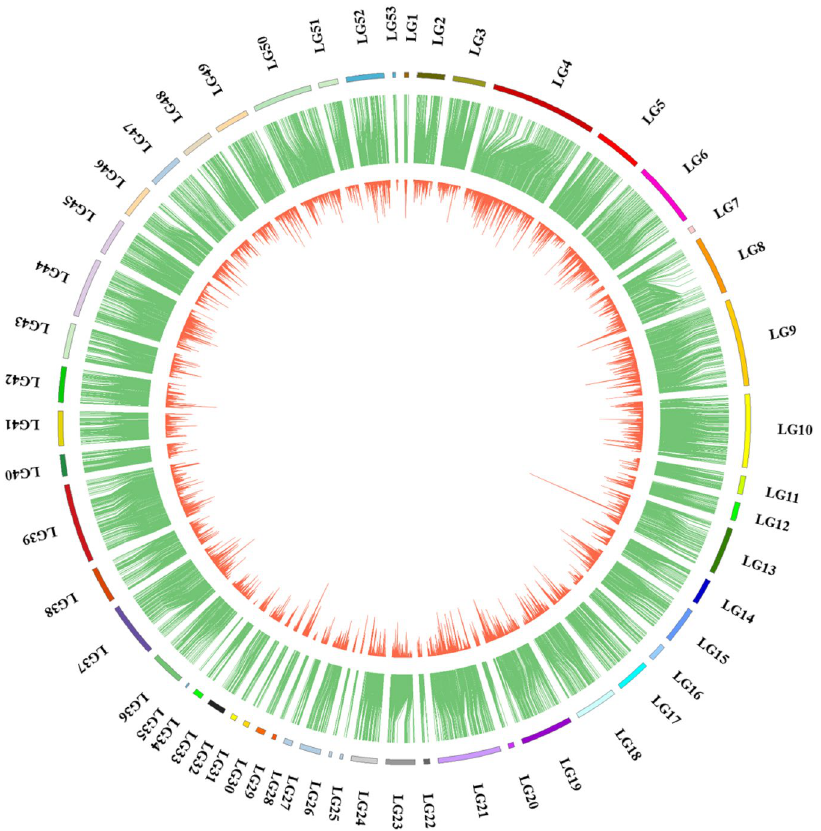
Figure 4. Integration of linkage map, genomic scaffolds/contigs and transcriptome unigenes. Outer ring, the linkage group; Intermediate ring, contigs or scaffolds of genome assembly aligned with markers from the linkage map; Inner ring, unigene sequences of transcriptome aligned with scaffold/contig sequences.